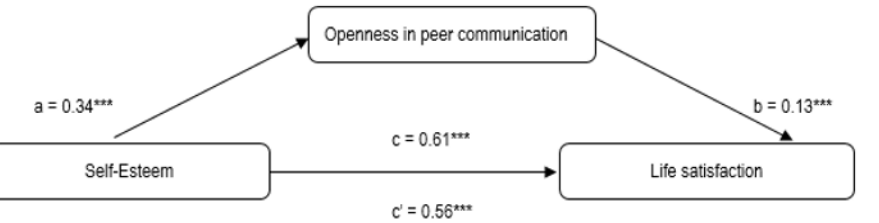
Figure 1. Results of mediation analysis of openness in peer communication in the relationship between self-esteem and life satisfaction; *** p < 0.001.